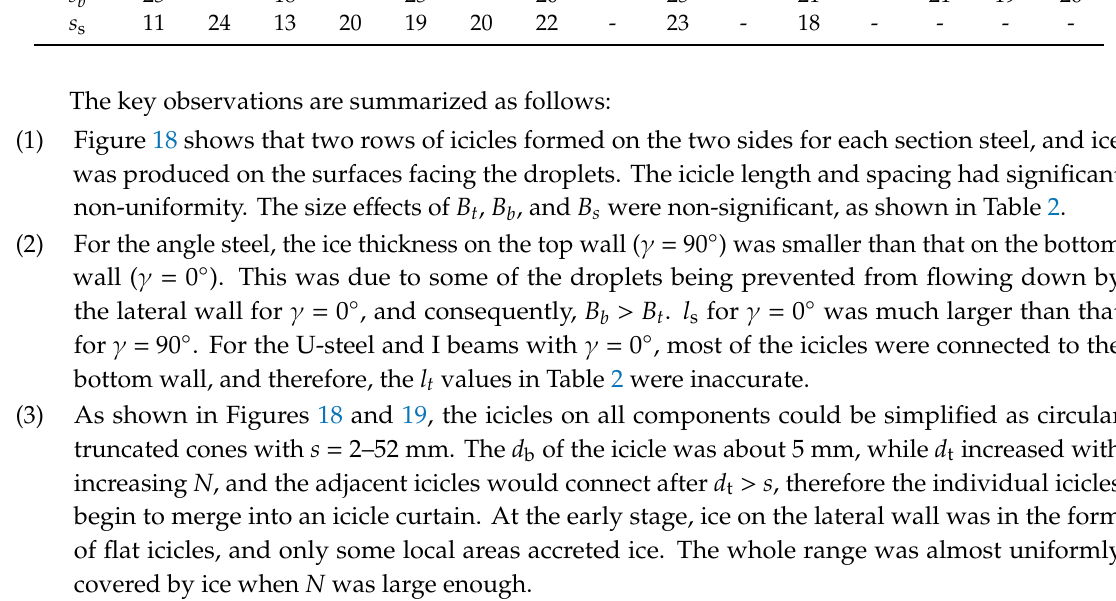
Table 2. Ice mean size of section steel for N = 80 (unit: